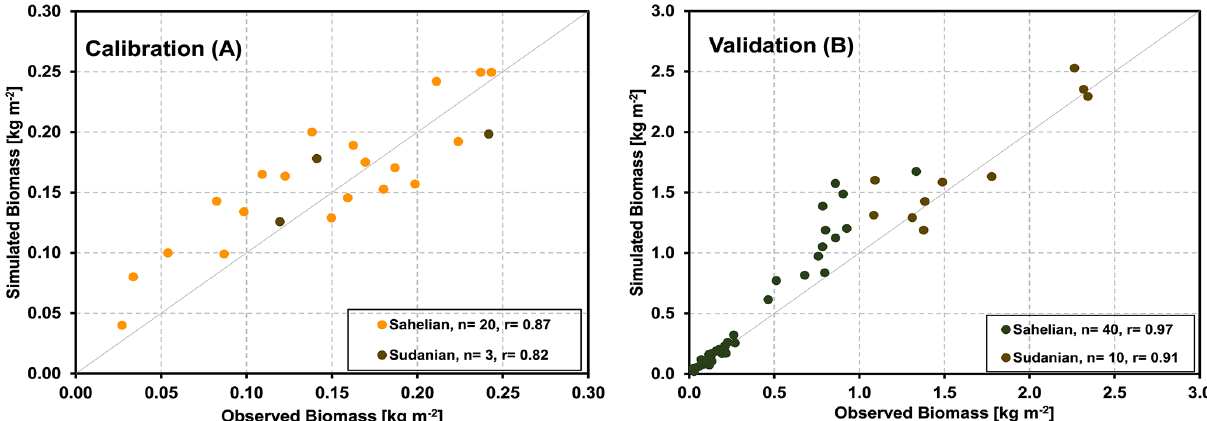
Figure 6. Correlations between the observed and modeled biomass production at different grass-dominated sites in the Sahelian and Sudanian ecological zones for the calibration (a) and validation (b)